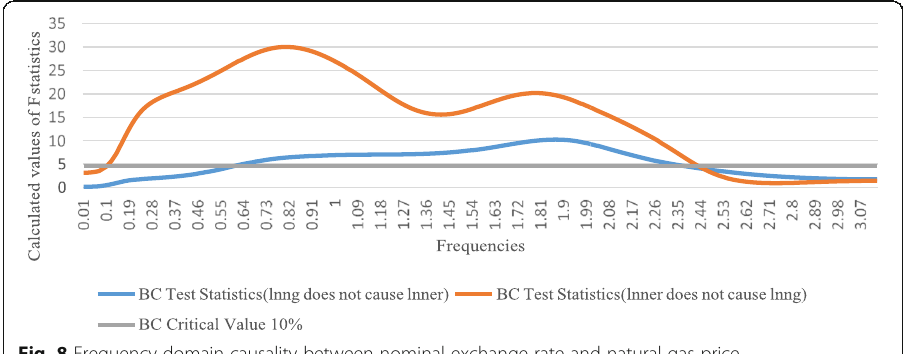
Fig. 8 Frequency domain causality between nominal exchange rate and natural gas